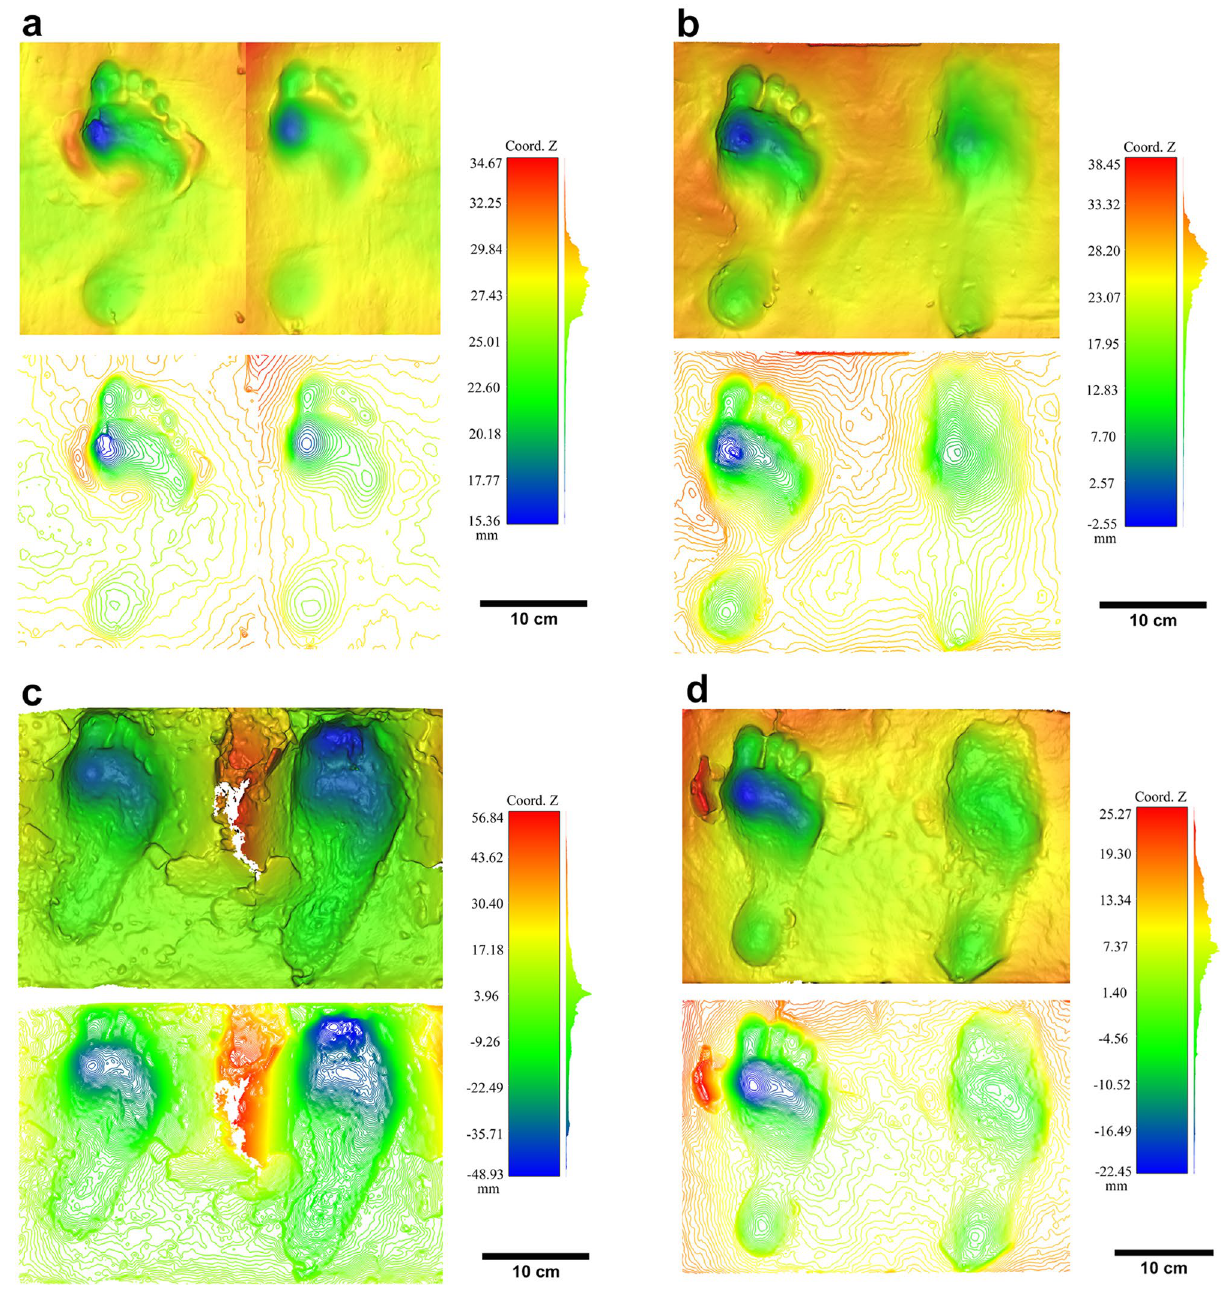
Figure 4. Depth maps and contour maps of some experimental barefoot prints and their associated footwear prints. ( a ) ch2 (without stuffing, moisture content of 50%); ( b ) ch6 (with stuffing, moisture content of 50%); ( c ) ch16 (without stuffing, moisture content of 60% 70%); ( d ) ch18 (stuffing, moisture content of 60%